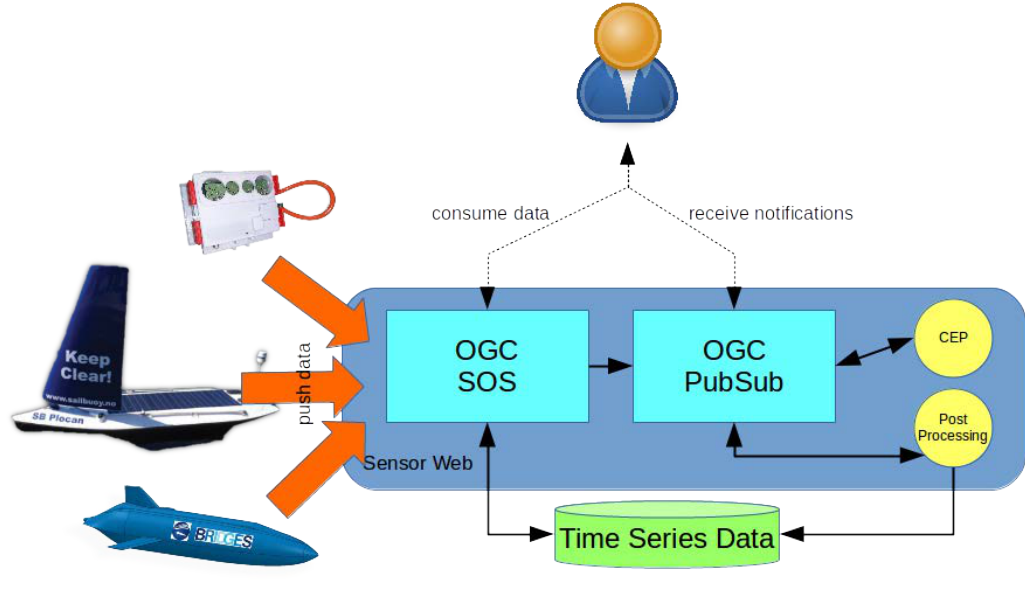
Figure 4. Sensor Web Architecture for Environmental Observation Data for Events of